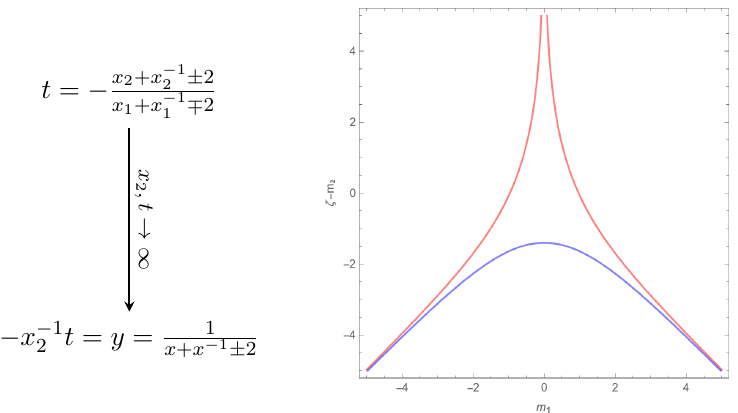
Figure 5 . Discriminant locus of CP 1 as obtained in the decoupling limit of that of SQED 2 . (For plotting purposes, m = 5 is chosen to represent x 2